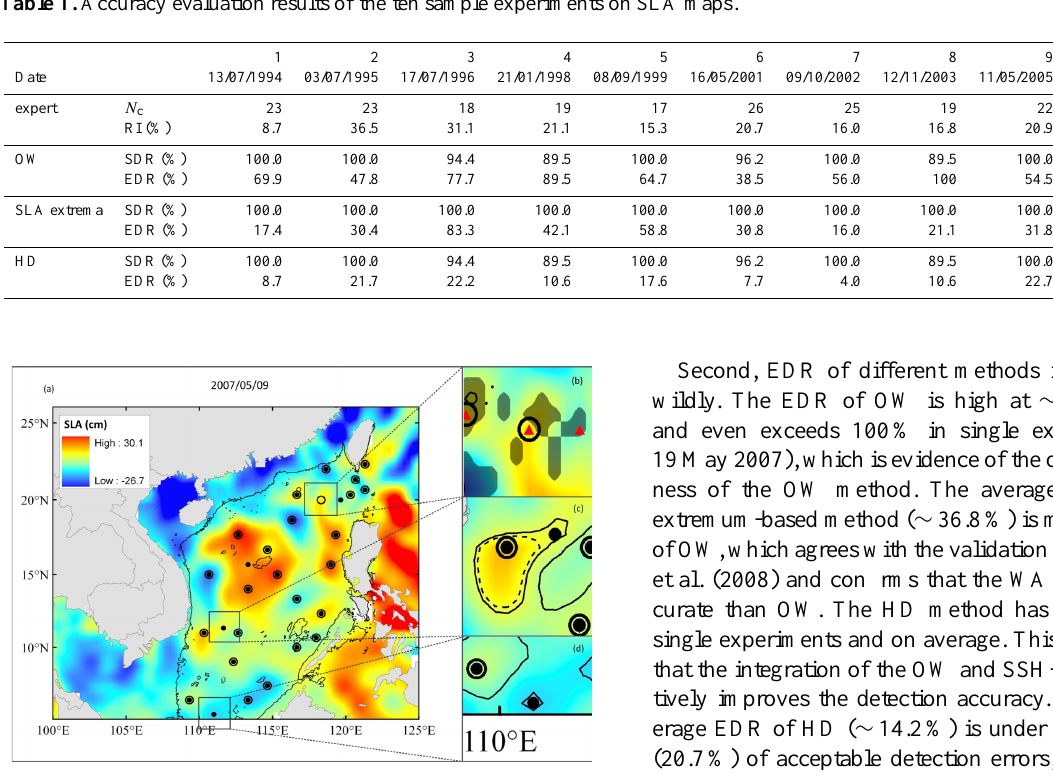
Table 1. Accuracy evaluation results of the ten sample experiments on SLA maps.